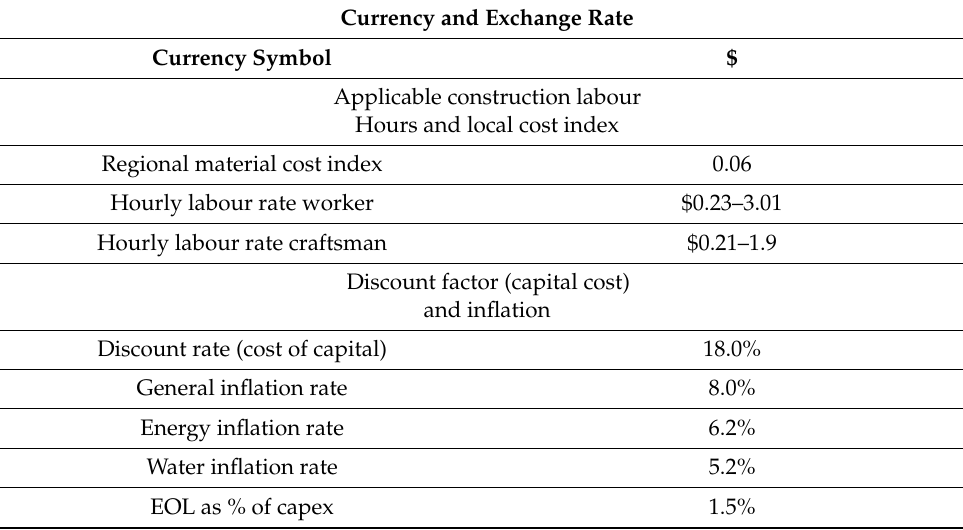
Table 8. The average cost parameter applied at the building level in Sub-Saharan Africa [35].